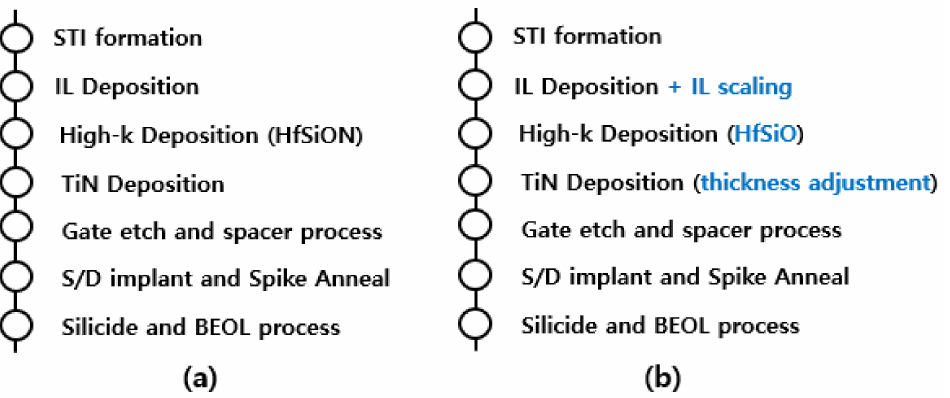
Figure 1. Fabrication process flow of ( a ) process-of-record (POR) and ( b ) the one proposed in this